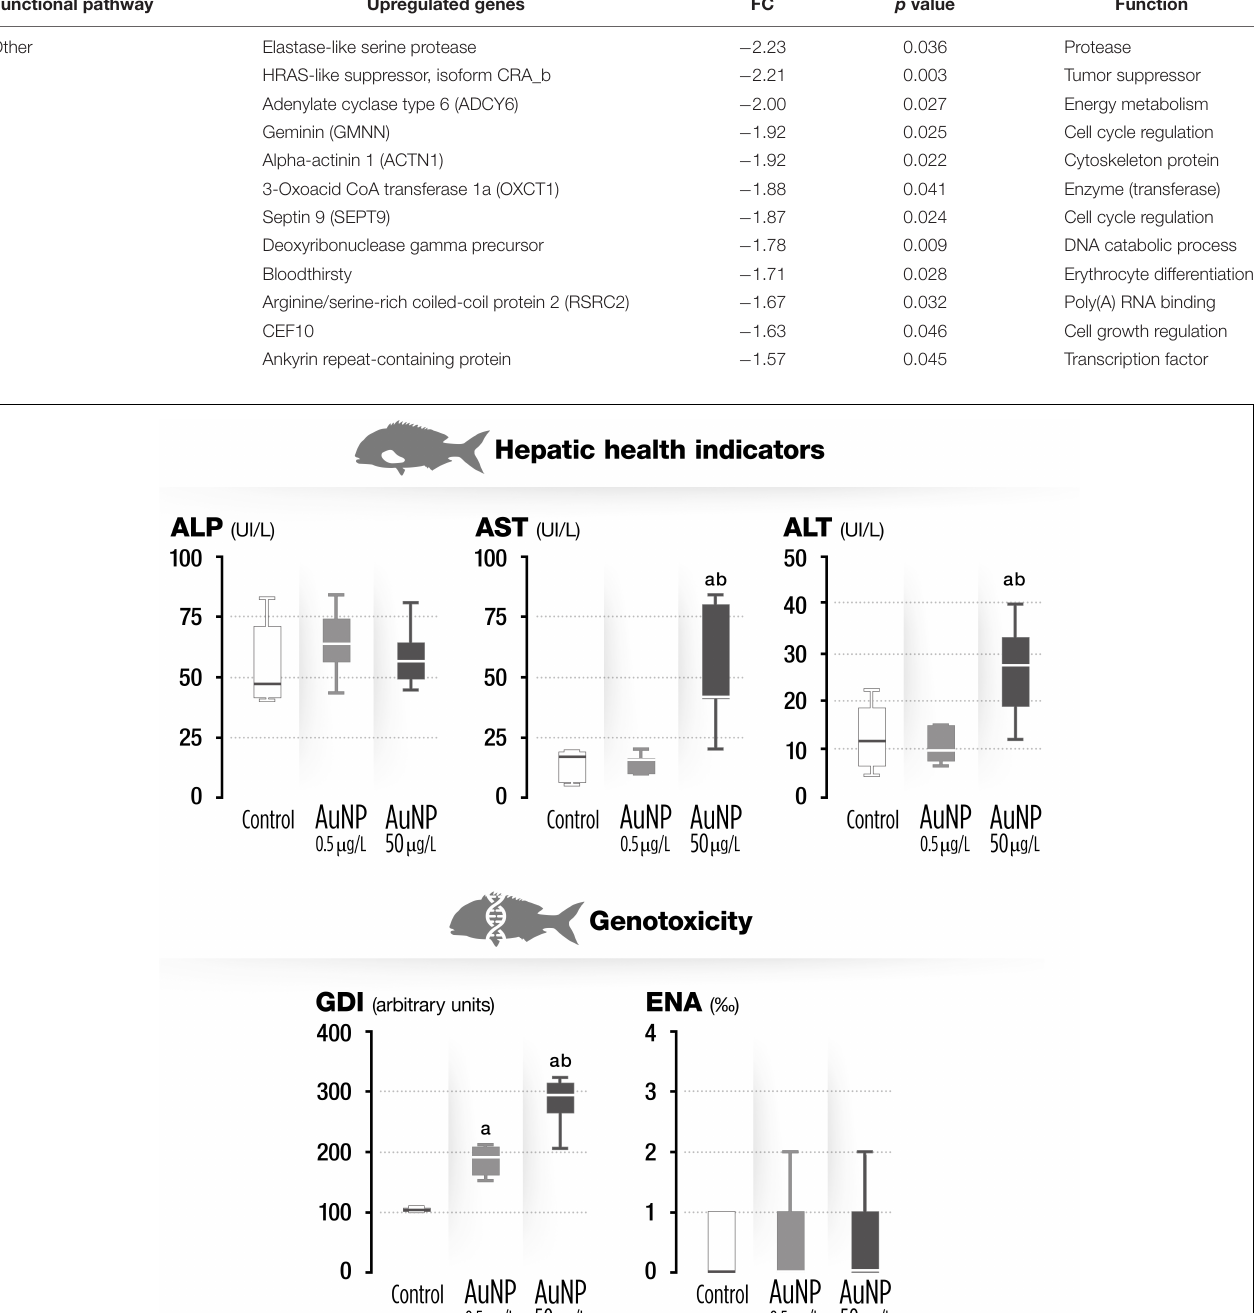
and 2 were significantly higher than in the control group, whereas in fish exposed to 50 µ g/L AuNP, significant increases in the classes 1, 2, 3, and 4 were found when compared to the